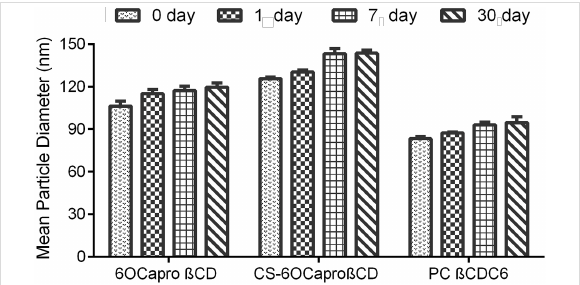
Figure 2: Time-dependent variation of particle size (nm) of PCX- loaded amphiphilic CD nanoparticles stored in aqueous dispersion form, ( n = 3, ±